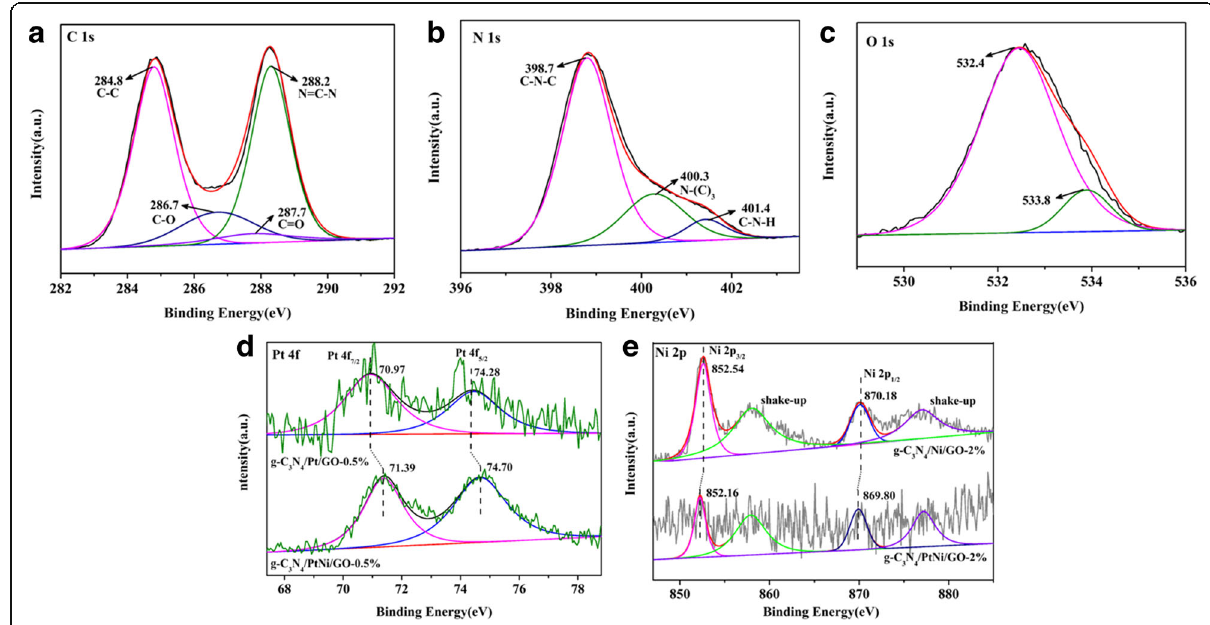
Fig. 3 XPS spectra of ( a ) C 1 s, ( b ) N 1 s and ( c ) O 1 s for the g-C 3 N 4 /PtNi/GO-0.5% sample. d XPS spectra of Pt 4f for the g-C 3 N 4 /Pt/GO-0.5% and g-C